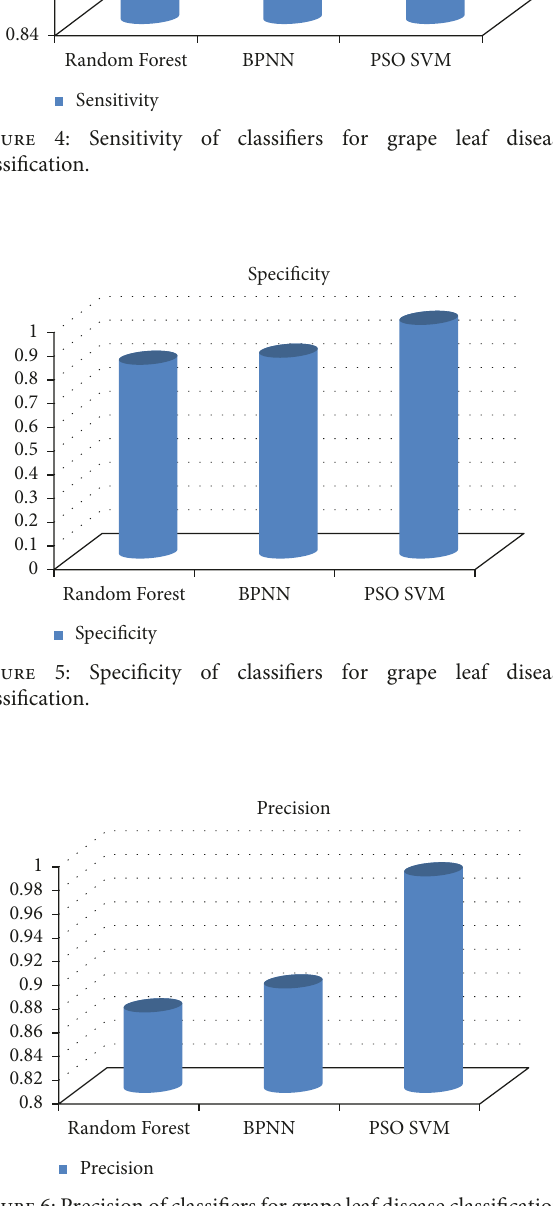
Figure 6: Precision of classifiers for grape leaf disease classification.